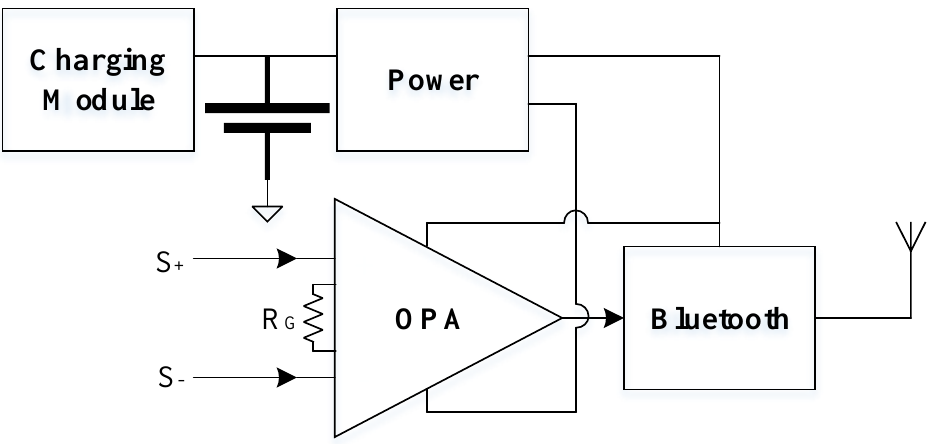
Figure 3. The structure of fetal heart sound collection module.